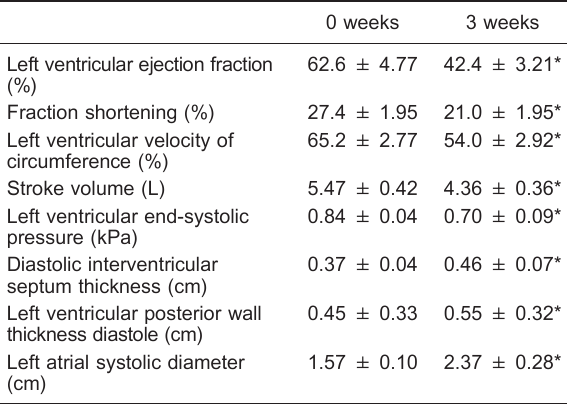
Table 1. Hemodynamic parameters in the pacing group at baseline and after 3 weeks.